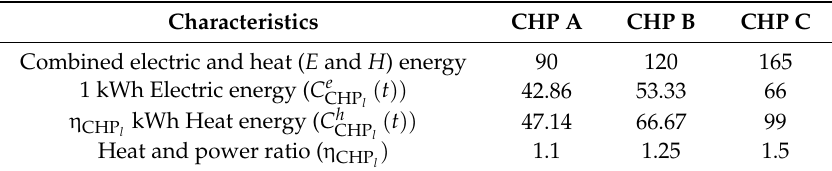
Table 1. Combined electric and heat ( E and H ) energy production cost of CHPs. Characteristics CHP A Combined electric and heat ( E and H )